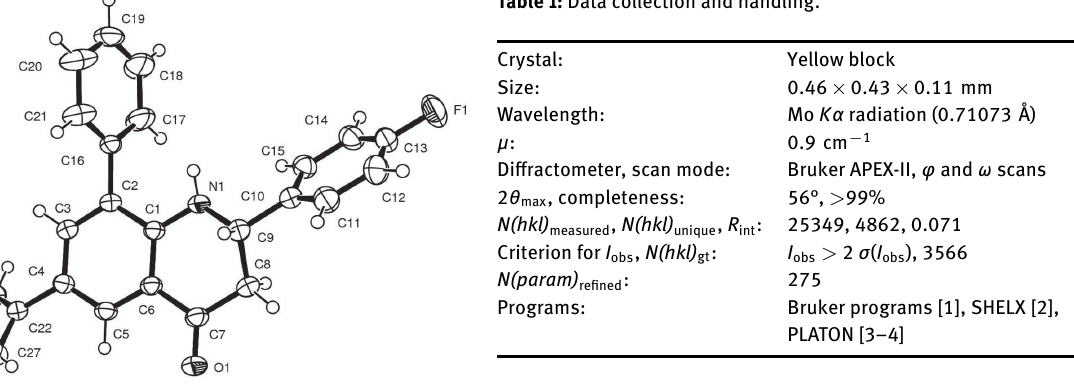
Table 1: Data collection and